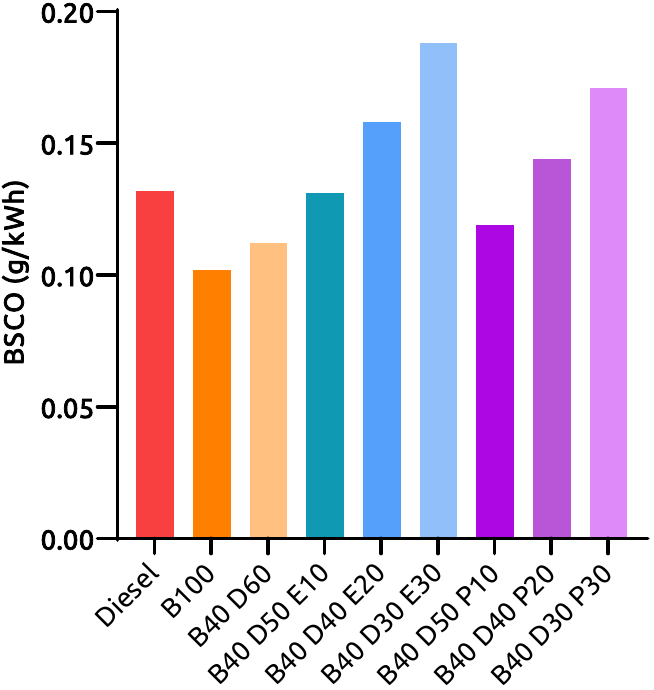
operation. Figure 7. Brake specific carbon monoxide emissions for tested fuels at full engine load. Figure 8 represents the BSHC results for all tested fuels at 100% engine loading con- dition. The BSHC values are 0.113 g/kWh, 0.069 g/kWh, and 0.092 g/kWh for diesel, B100, and B40D60, respectively. 0.100 g/kWh, 0.121 g/kWh, and 0.143 g/kWh of BSHC emissions were observed for B40D50P10, B40D40P20, and B40D30P30 propanol-based ternary blends, respectively. On the other hand, engine operation with the ethanol-containing blends B40D50E10, B40D40E20, and B40D30E30 gave 0.110 g/kWh, 0.131 g/kWh, and 0.152 g/kWh, respectively. When compared to B40D60 binary blend engine operation, B40D50E10, B40D40E20, and B40D30E30 blends showed a growth of 0.018 g/kWh, 0.039 g/kWh, and 0.060 g/kWh, while a rise of 0.008 g/kWh, 0.029 g/kWh, and 0.051 g/kWh was